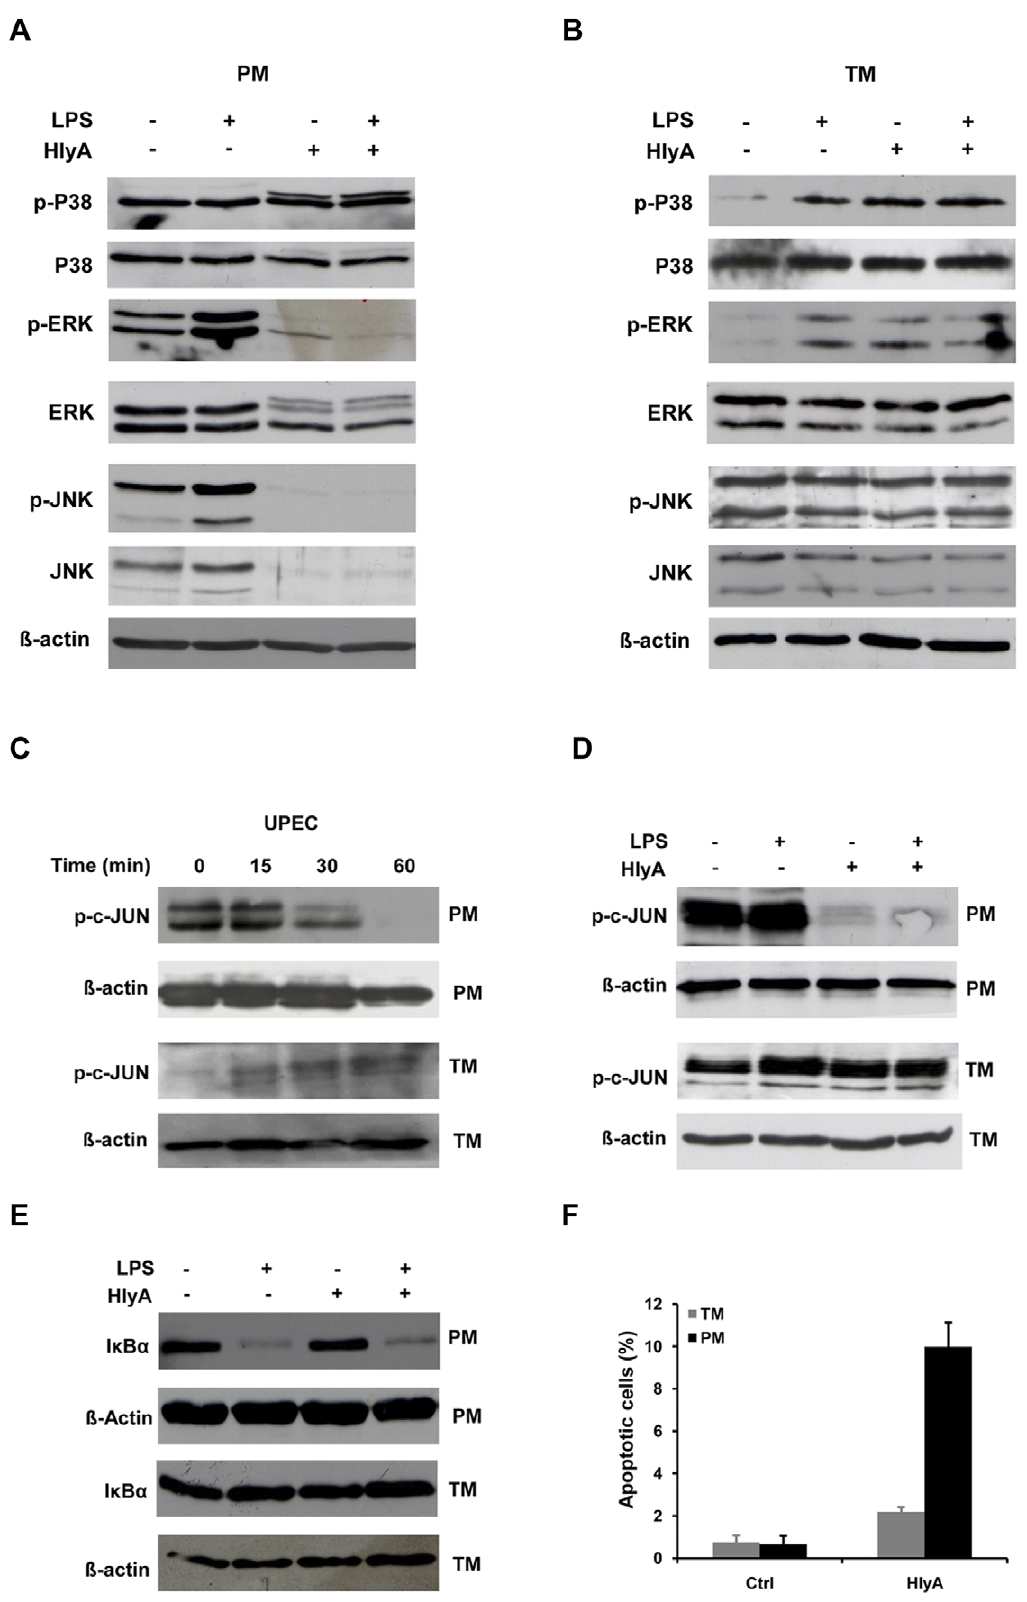
Figure 7. HlyA suppresses MAP kinase activation. ( A ) PM and ( B ) TM were treated with 10 m g/ml LPS and 40 ng/ml of alpha-hemolysin (HlyA) for 30 min as indicated. For Western blot analysis 20 m g of protein were separated by 10% SDS-PAGE and immunoblots were probed with antibodies specific for the phosphorylated forms of MAP kinases p38 (p-P38), JNK (p-JNK) and ERK 1/2 (p-ERK1/2), respectively. Changes in the total amount of